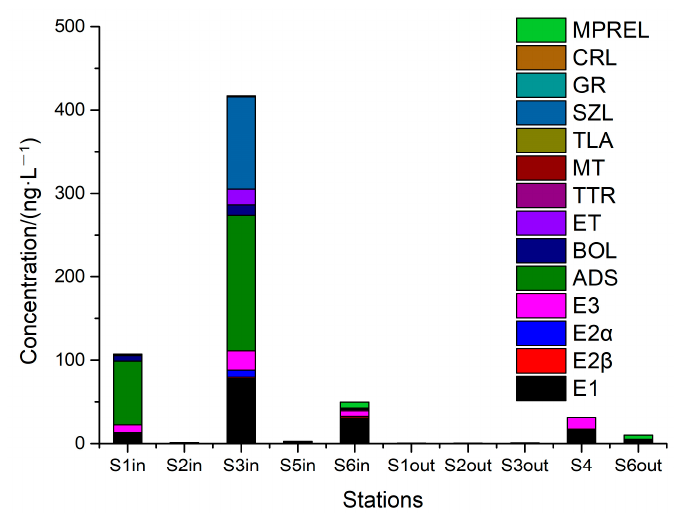
Figure 3. Distribution of steroids in the inlets and outlets of municipal sewage treatment plants.